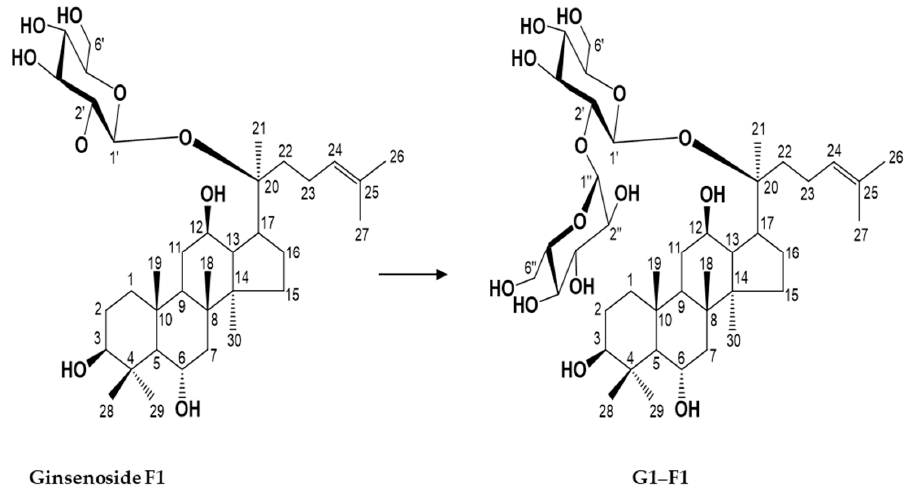
Figure 2. Chemical structures of ginsenoside F1 and its α‐ glycosylated